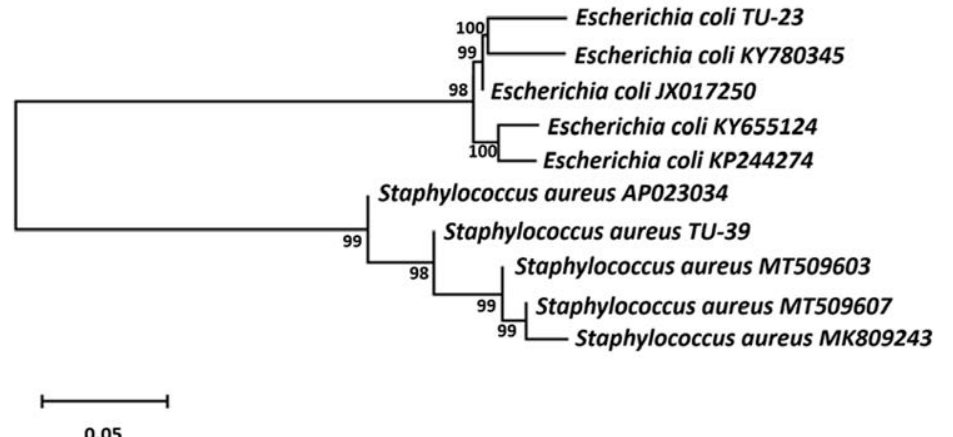
Fig. 1 . The phylogenetic relationship tree of E. coli TU-23 and S. aureus TU-39, which are considered in the present study with related genera, based on the sequence of 16S rRNA gene sequences using neighbor-joining method in MEGA 7